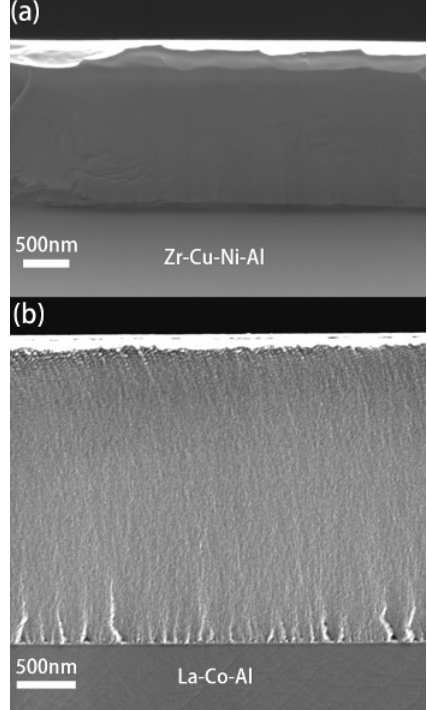
Figure 1. Typical cross-sections of: ( a ) Zr-Cu-Ni-Al; and ( b ) La-Co-Al films using scanning electron micrograph (SEM), film thickness could be measured.